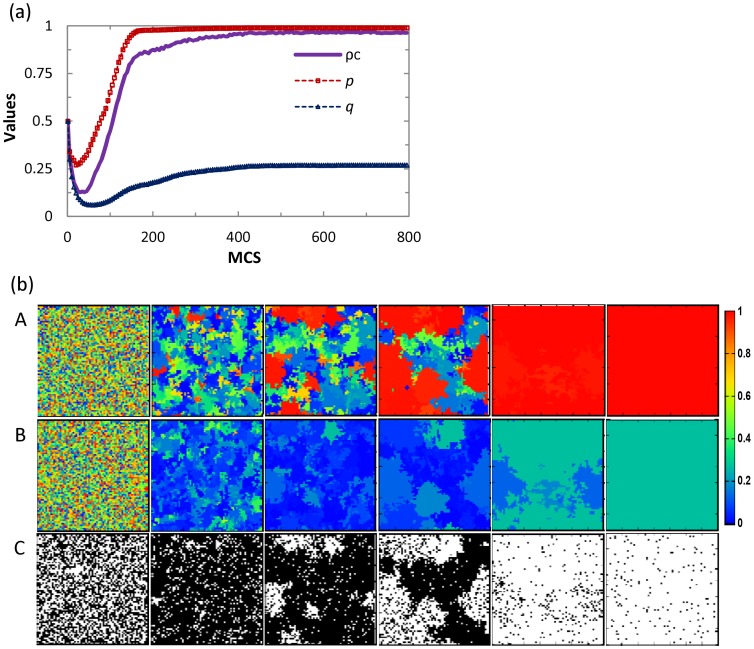
(a) Time courses for the evolution of cooperation and strategy profile p, q at Dg = Dr = 1.(b) The corresponding snapshots for the corresponding evolution course. (b)-A shows parameter p; (b)-B shows parameter q and the behaviors of cooperators (C, white) or defectors (D, black) are presented in the panel of (b)-C. For these snapshots, the time steps from left to right are 0, 20, 60, 100, 300 and 700, respectively.